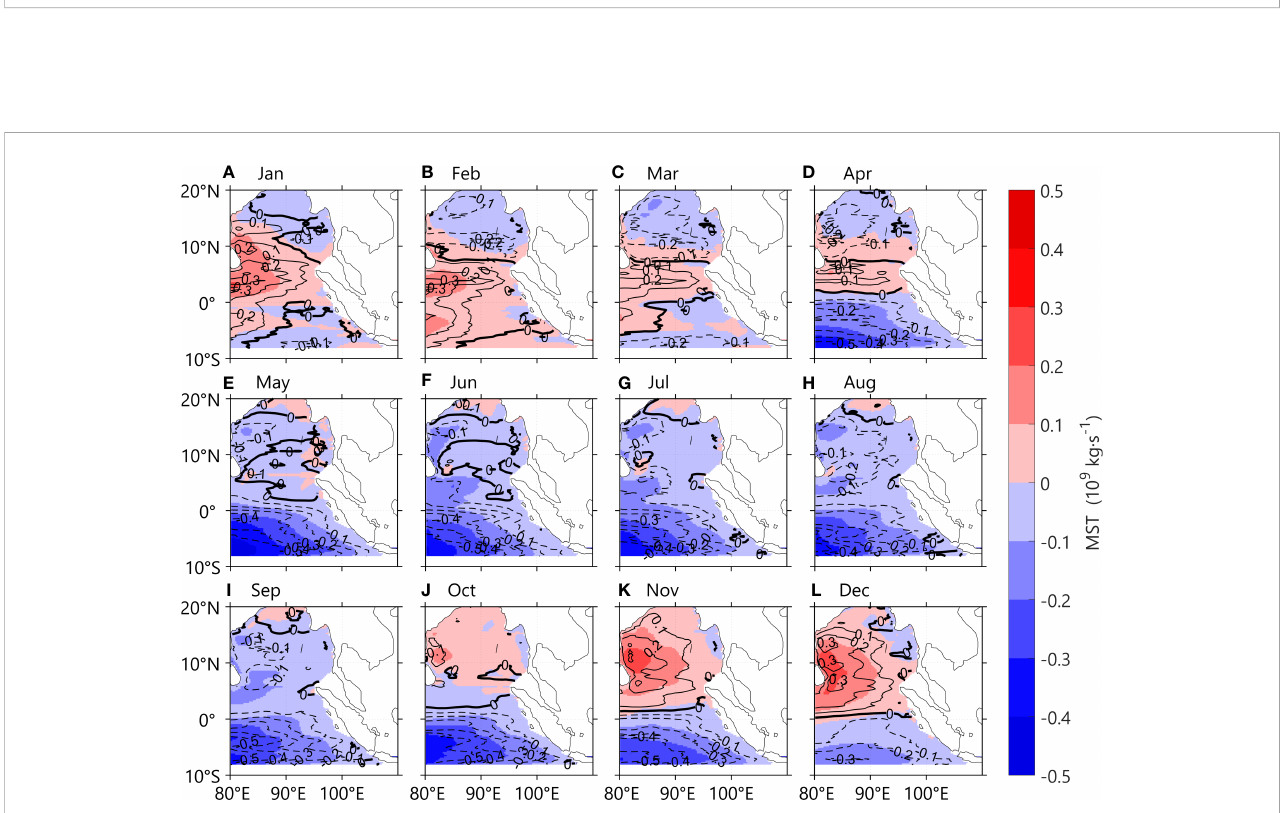
FIGURE 10 Monthly meridional heat transport (A-L) based on the ECCO2 (shading) and the observation data (drifter-derived currents and Argo data, contours), respectively. Positive values are northward transports. Unit: